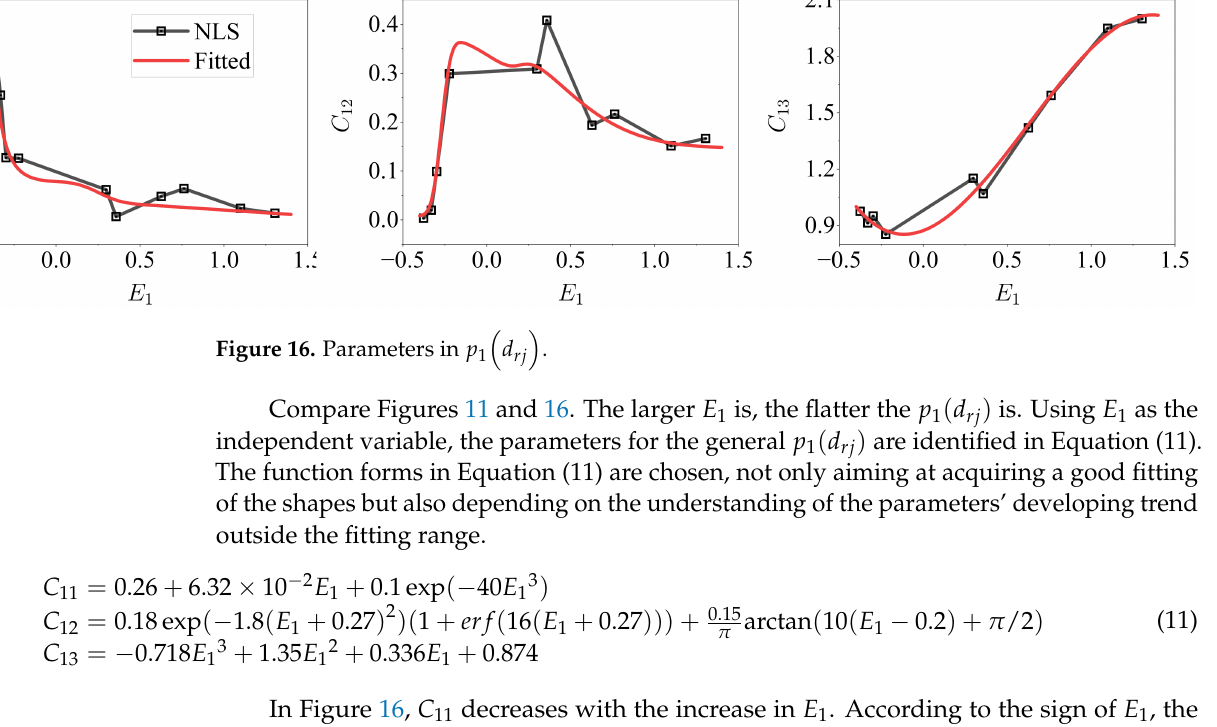
Figure 16. Parameters in p 1